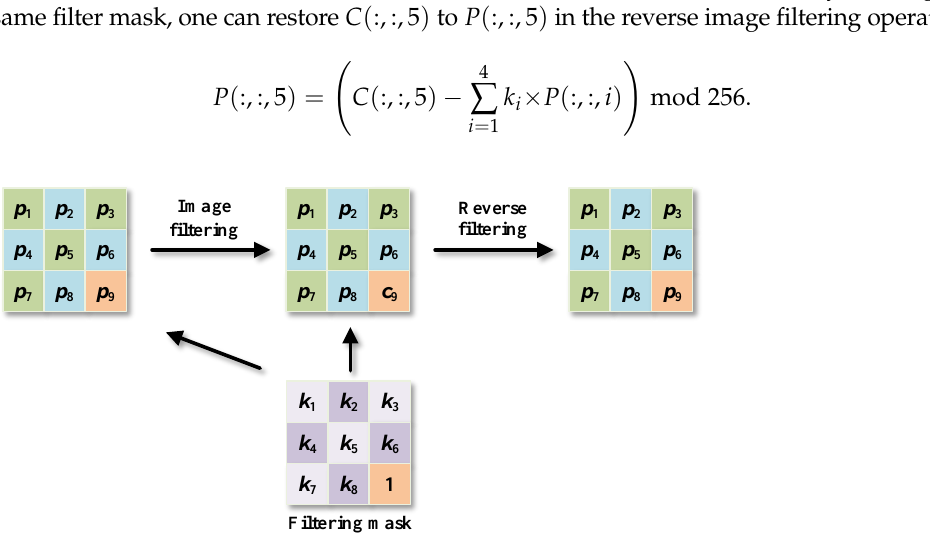
Figure 4. Basic principle of pixel-level image filtering.